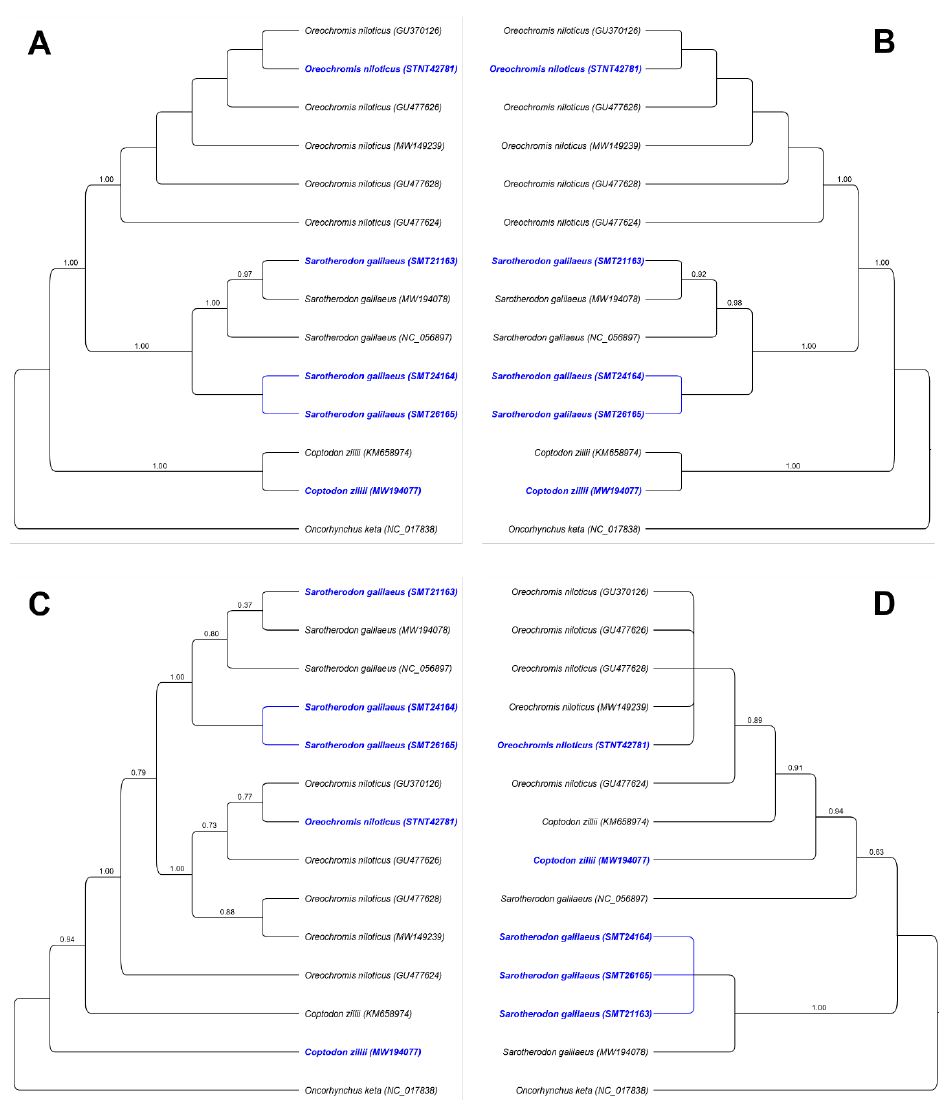
Figure 5. Maximum likelihood inference-based phylogeny showing the mitogenomic relationship using ( A ) complete mitogenome, ( B ) CDS, ( C ) D-loop, and ( D ) IGS, between the Nile tilapiine species ( C. zillii , O. niloticus , and S. galilaeus ). Samples under study are highlighted with a different color. Each label includes the species name and the GenBank accession number. The numbers at the nodes indicate the bootstrap values.